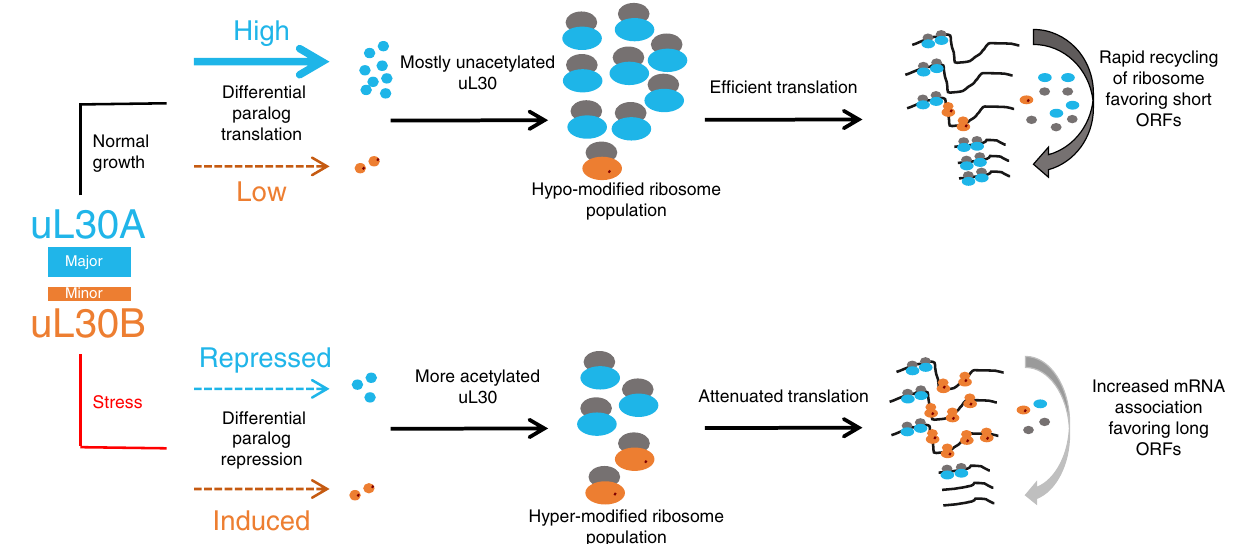
Fig. 7 | Schematic representation of a hypothetical model for paralog- dependent modulation of translation. Expression of the major and minor ul30 paralogs and their impact on translation is depicted under normal growth condi- tions or after exposure to stress (e.g., staurosporine). In this model, the major paralog (uL30A, shown in blue) is predominantly translated under normal growth condition(shownontop)leadingtothegenerationofahighlyactivepopulationof ribosomes incorporating the hypo-modi fi ed version of uL30. These ribosomes supportef fi cienttranslationcyclesandreducetheassociationtimewithlongORFs which in turn permits repeated translation of genes with short ORFs. In contrast, when cells are exposed to drugs (shown at bottom), the translation of the major